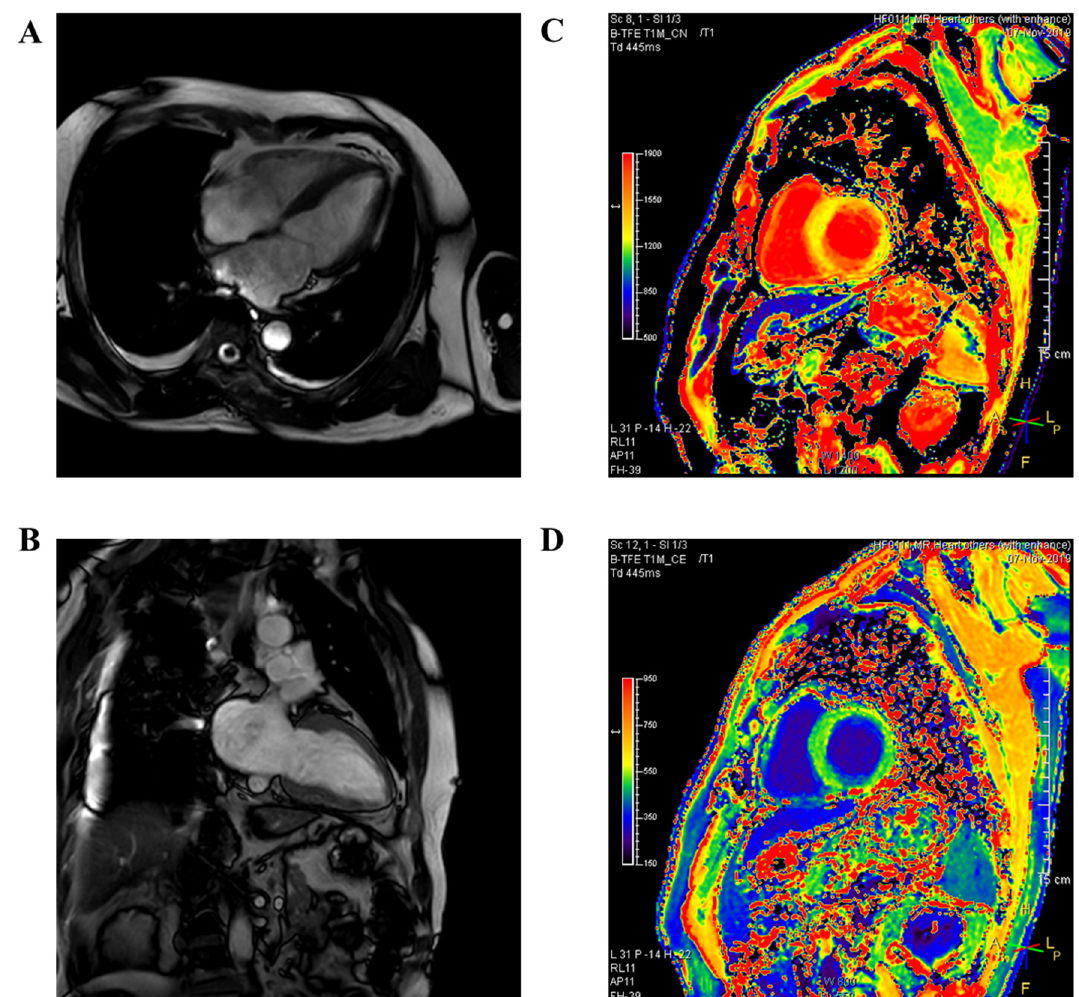
Figure 2. CMR scan suggesting non-ischemic cardiomyopathy. ( A , B ) Cine view (4 and 2 chambers). ( C ) Pre-T1 map. The T1 value is diffusely increased in the LV wall, except the lateral and inferior walls. ( D ) Post-T1 map. The T1 value is diffusely decreased in the LV endocardium.